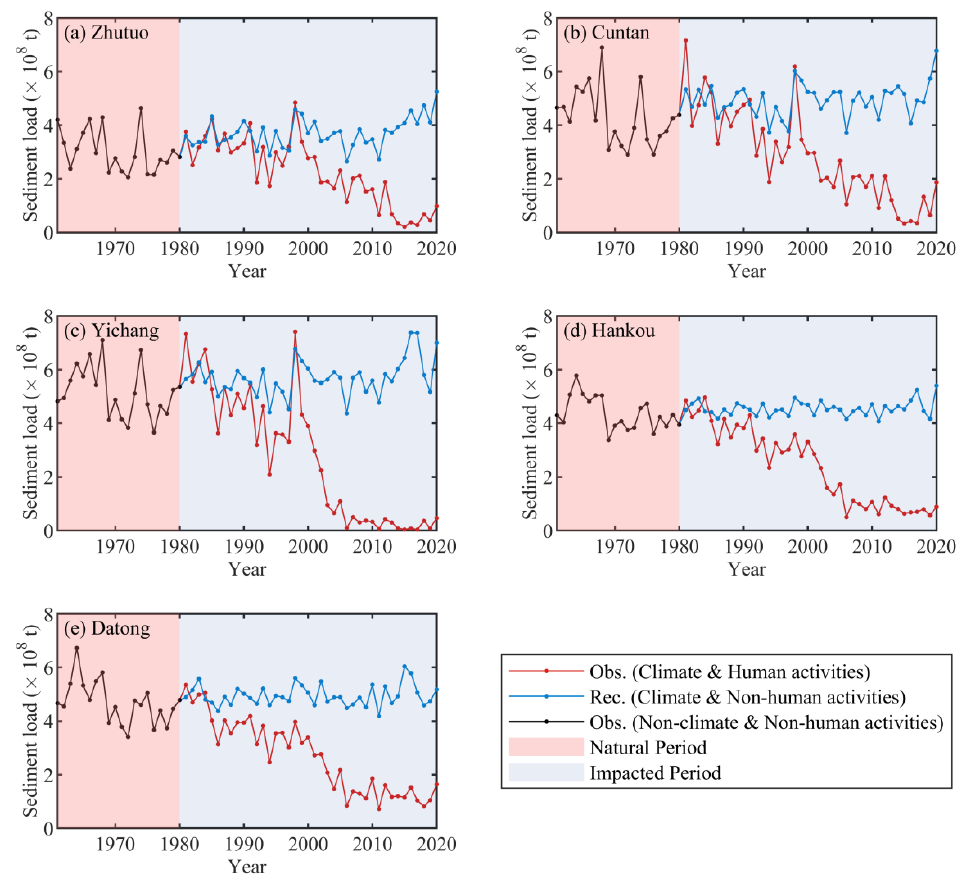
Figure 9. Variations of observed and reconstructed sediment load at five hydrological stations.